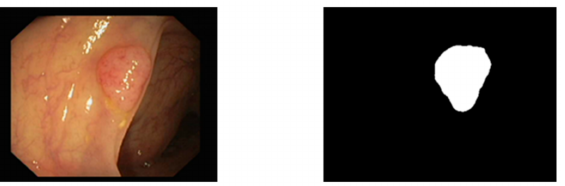
final prediction map. Figure A3 shows the raw colonoscopy image used for visualisation purposes and its ground truth for reference.